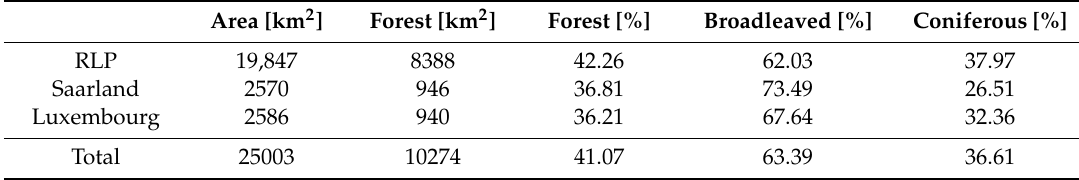
Figure 1. Map of the study area. Forest areas based on cadastral data are depicted in light green. Table 1. Overview of the forest cover and proportional forest cover considering the forest